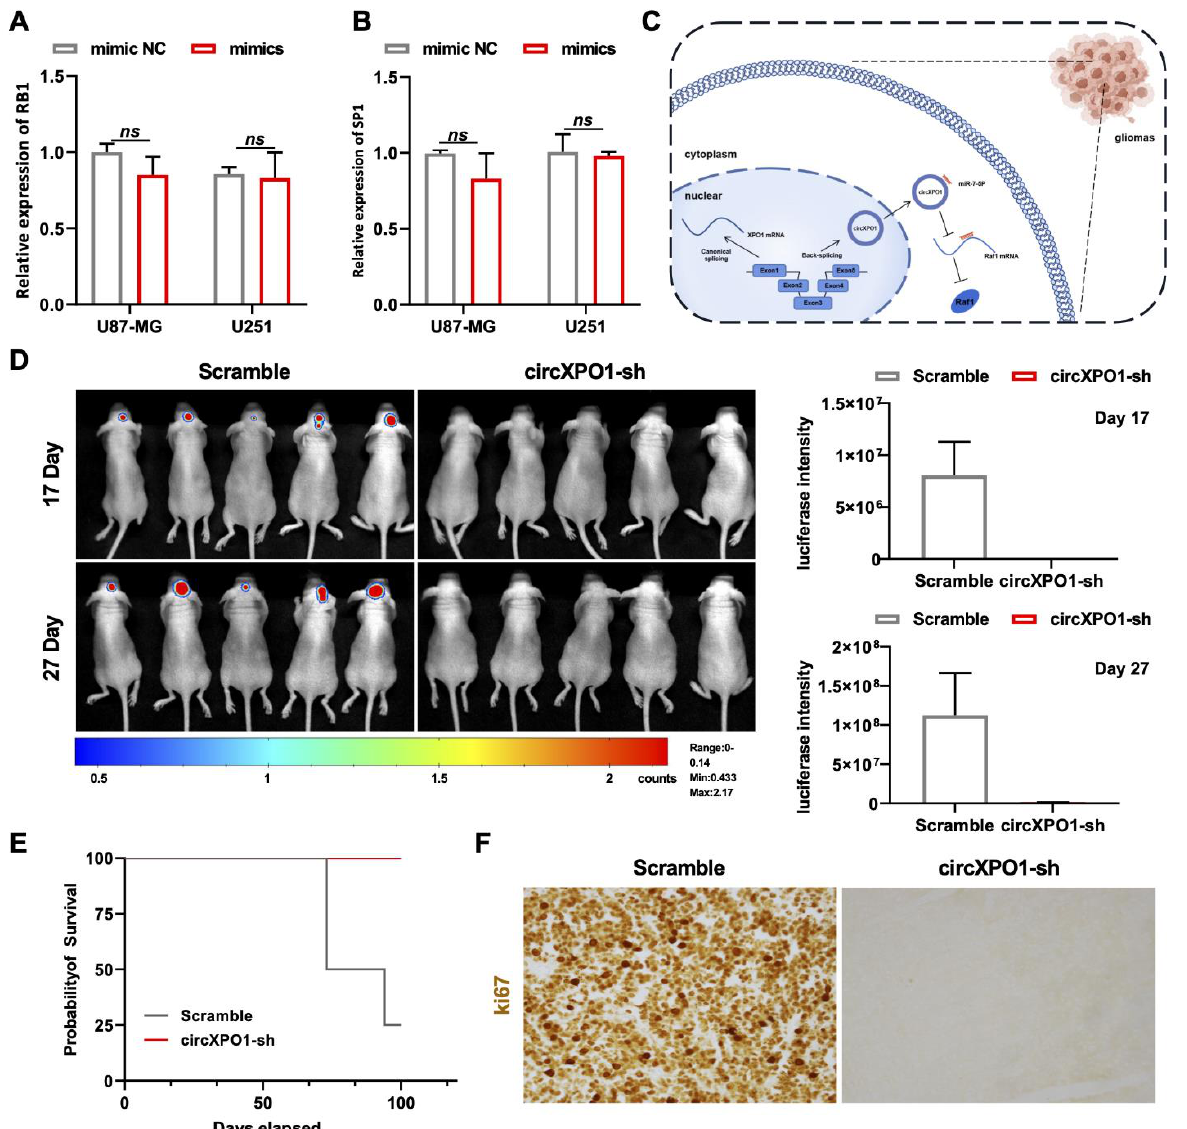
Figure 5. circXPO1 suppression inhibits GBM progression in vivo. ( A , B ) The expression of RB1 and SP1 was almost unaffected by miR-7-5p mimics. ( C ) Schematic representation of circXPO1-mediated GBM-promoting function. ( D ) Bioluminescent images of the intracranial tumors of nude mice (5 mice for each group) on day 17 and 27 post stereotaxic orthotopic implantation of GBM cells. ( E ) Survival curve of model mice transplanted with circXPO1-sh or scramble control GBM cells. ( F ) Immunohistochemical staining of Ki67 revealed major cell cycle inhibition in circXPO1-sh group.